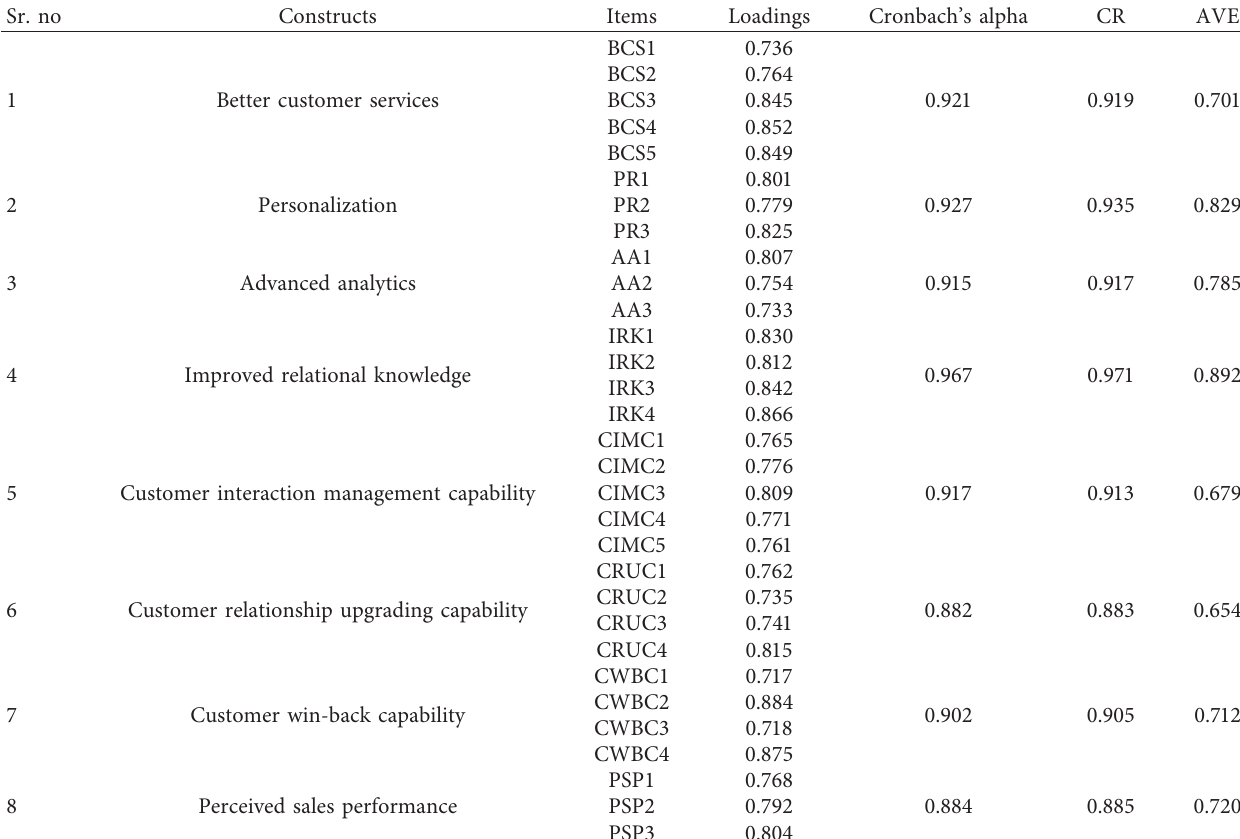
Table 5: Results of factor loadings, Cronbach’s alpha, composite reliability (CR), and AVE. Sr.